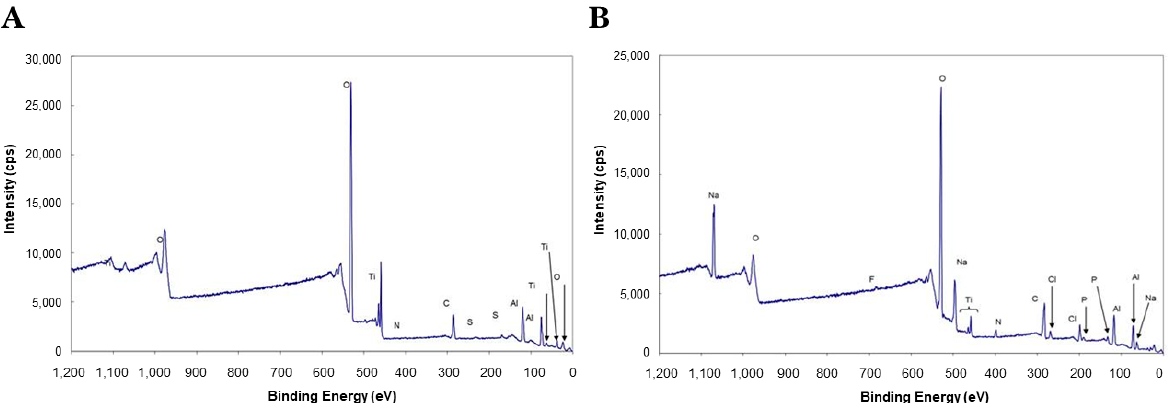
Figure 2. X-ray photoelectron spectrometer (XPS) analysis for uncoated Ti disk ( A ) and DMP1 coated Ti disk ( B ).